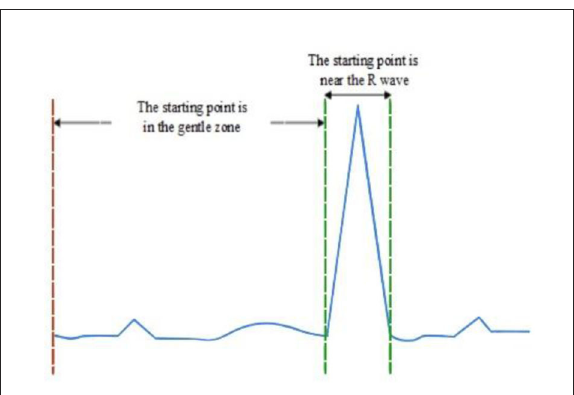
FIGURE2 Schematic diagram of starting point selection area for R-wave